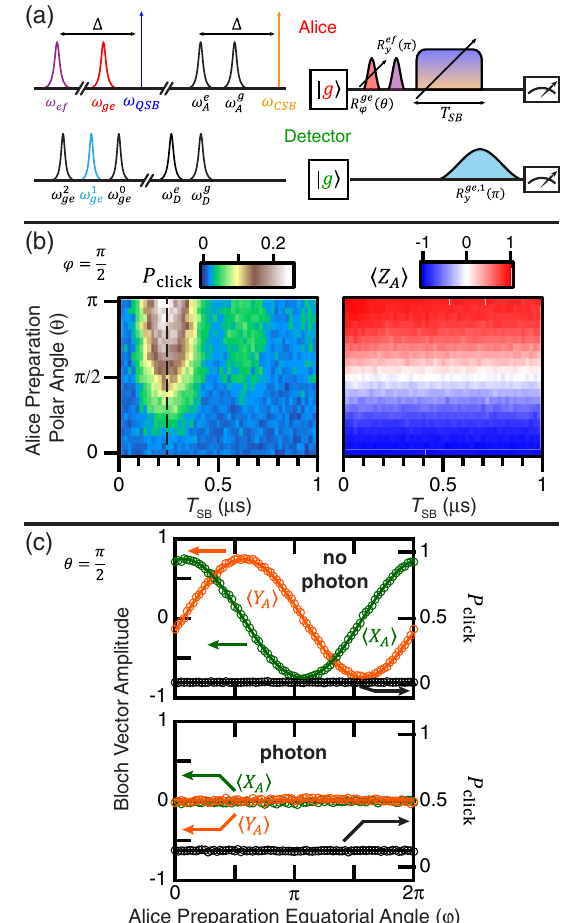
FIG. 2. Signatures of qubit or flying photon entanglement. (a) Frequency spectra of the Alice and detector qubit-cavity systems (left) and experimental pulse sequence (right). The colors denote transitions which are driven to perform the CNOT-like operation and flying single-photon detection. The Alice qubit is prepared in an arbitrary initial state by the pulse R ge ϕ ð θ Þ at ω . The ge π Þ pulse at ω CNOT-like operation consists of a R followed by y ð ef , a pair of sideband pulses. The sideband pulses are applied at ω QSB detuned by Δ from ω , and ω , detuned by Δ from ω e . To ef CSB A detect flying photons, a frequency-selective π -pulse is applied to the detector qubit at ω 1 , followed by a measurement of the qubit ge state. (b) Color plots of the probability P of the detector qubit click ending in j e i (left) and the Alice qubit polarization h Z (right), as A i a function of the sideband pulse length T and θ (for ϕ ¼ π = 2 ). SB 254 ns corresponds to a transfer The dashed line at T SB ¼ j f 0 i → j e 1 i , i.e., a CNOT-like operation. (c) Detector click probability P and Alice equatorial Bloch vector components click h X A i and h Y A i , as a function of ϕ for θ ¼ π = 2 when the CNOT-like operation is either performed (bottom) or not (top). Open circles are experimental data, and lines are photon detection process. Measuring the qubit in the excited state corresponds to a photon detection event (click). Finally, the detector is reset by returning the qubit to j g i with an unselective π -pulse.